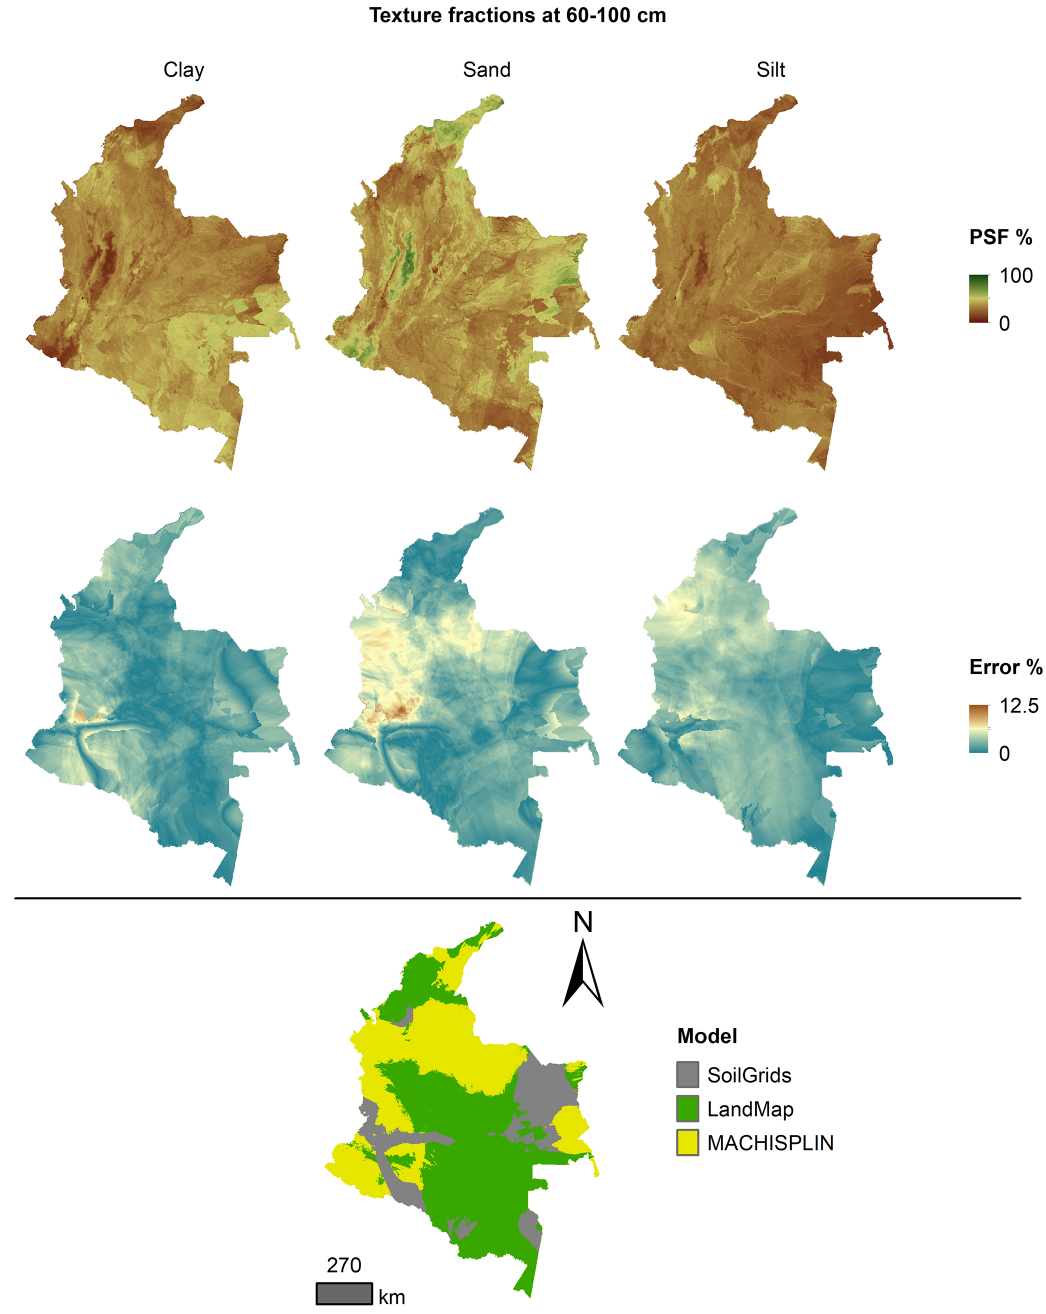
Figure 9. Ensemble model, percentage error distribution, and best model selected at